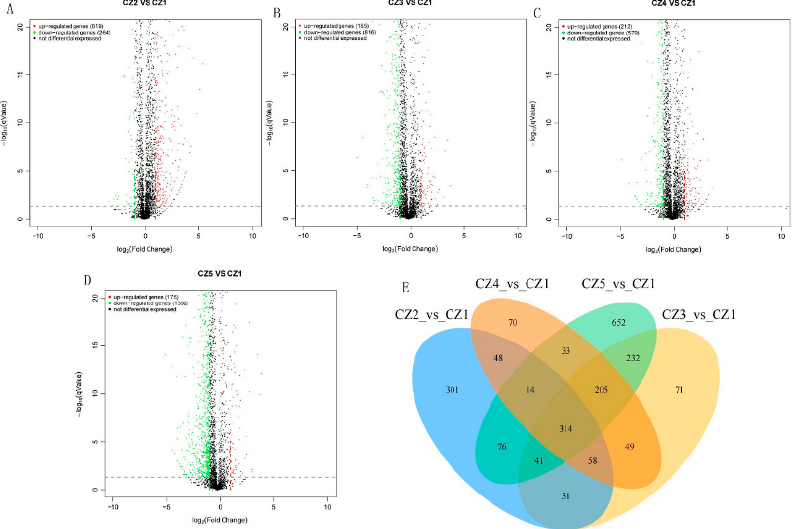
Figure 3. Analysis of differentially expressed genes (DEGs). ( A – D ) The horizontal axis indicates the differential expression multiplicity fold-change (log (B/A)) value of the gene, while the vertical axis indicates the statistical significance of the change in gene expression p-value. The smaller the p-value, the larger the − log (p-value), and the more significant the difference. ( E ) The numbers in the graph indicate the number of genes that are specific or common between the comparison groups.